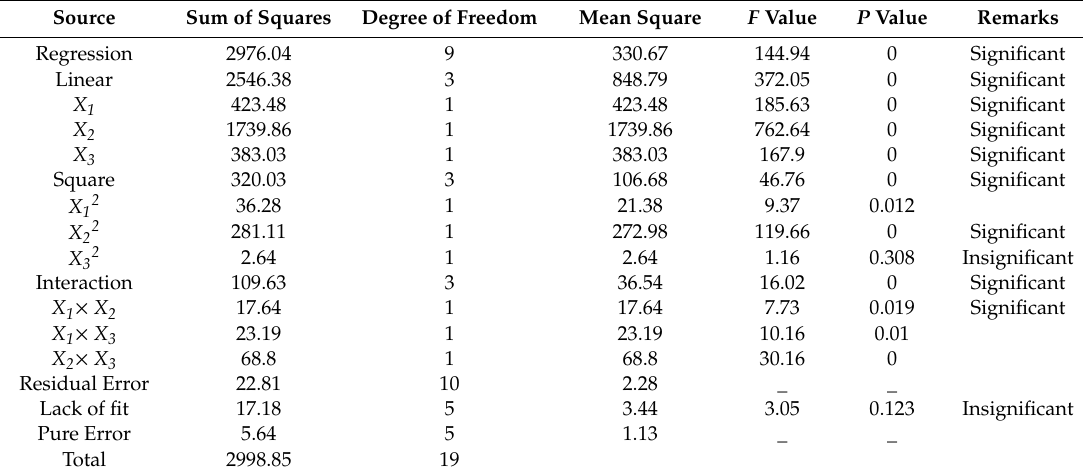
Table 3. ANOVA of chromium removal.